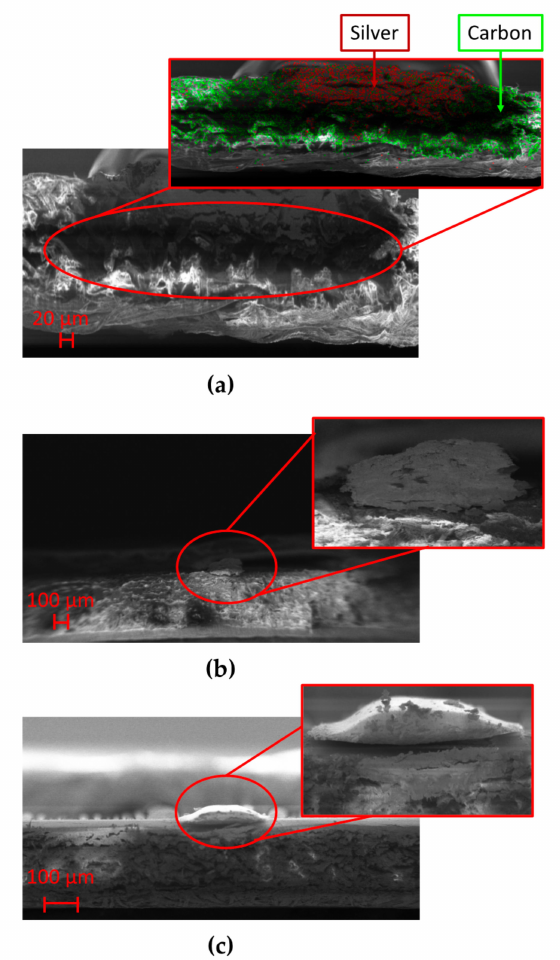
Figure 6. Cross-section magnification performed thanks to the abovementioned field emission scanning electron microscope (FE-SEM) for samples printed on ( a ) chromatographic paper, ( b ) cardboard, and ( c )